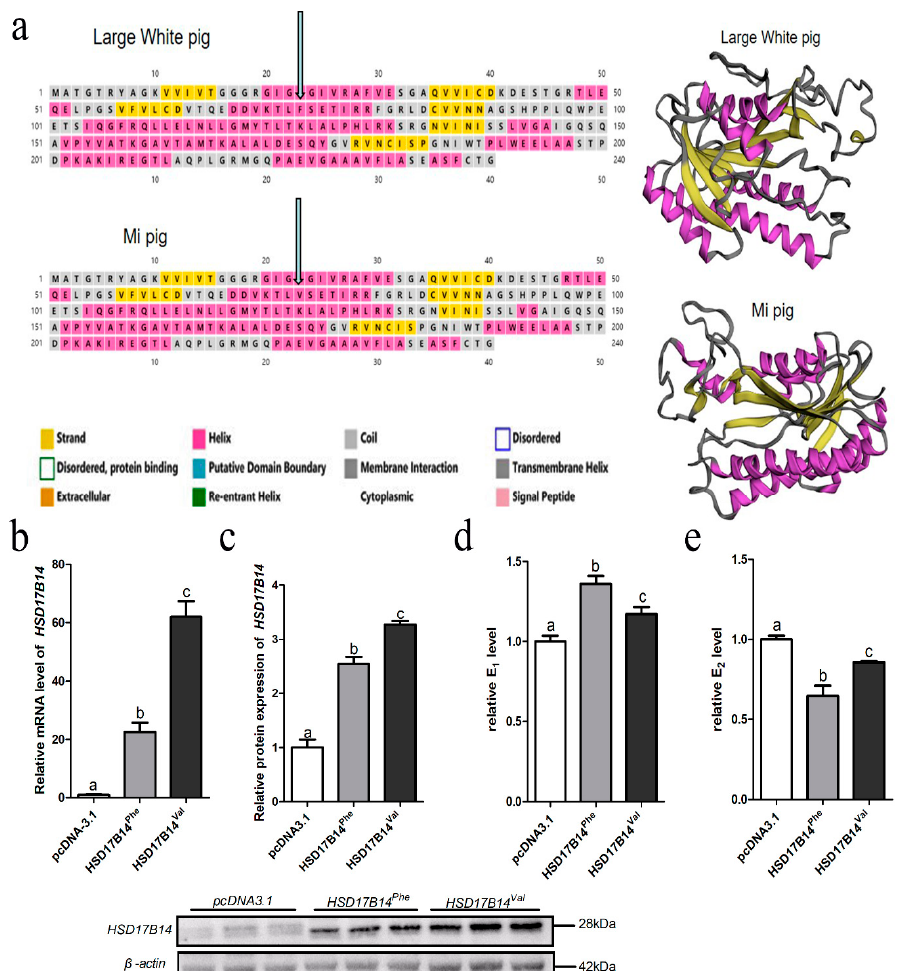
Figure 4. Differential expression and function of the Phe73Val of porcine HSD17B14 gene in porcine ovarian granulosa cells (GCs). Bioinformatics website PSIpred-MEMSAT3 was used to analyze the structural differences of proteins and build a three-dimensional model. ( a ) Secondary structure of protein of in Large White pigs and three dimensional image construction based on the secondary structure of protein of Large White pigs. Secondary structure of protein in Mi pigs and three dimensional image construction based on the secondary structure of protein of Mi pigs. ( b ) RT-qPCR analyses of HSD17B14 mRNA expression in porcine GCs transfected with HSD17B14 Phe , HSD17B14 Val or pcDNA3.1 (+ ). The mRNA levels were normalized to GAPDH . ( c ) Western blot analyses of HSD17B14 protein expression in porcine GCs transfected with HSD17B14 Phe , HSD17B14 Val and pcDNA3.1 (+ ). The protein levels were normalized to β -actin. ( d ) E 1 concentration (IU/L). The cell supernatants were collected 48 h after transfection and examined using porcine E 1 ELISA kits. ( e ) E 2 concentration (IU/L). The cell supernatants were collected 48 h after transfection and examined using porcine E 2 ELISA kits. Each experiment was repeated three times and data are shown as means ± S.E.M. p -values were calculated by t -tests, different letters (a, b and c) indicate that the difference is significant ( p < 0.05).